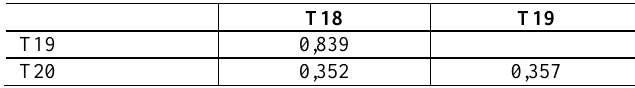
Table 5: Correlation coefficients for Technology (T)